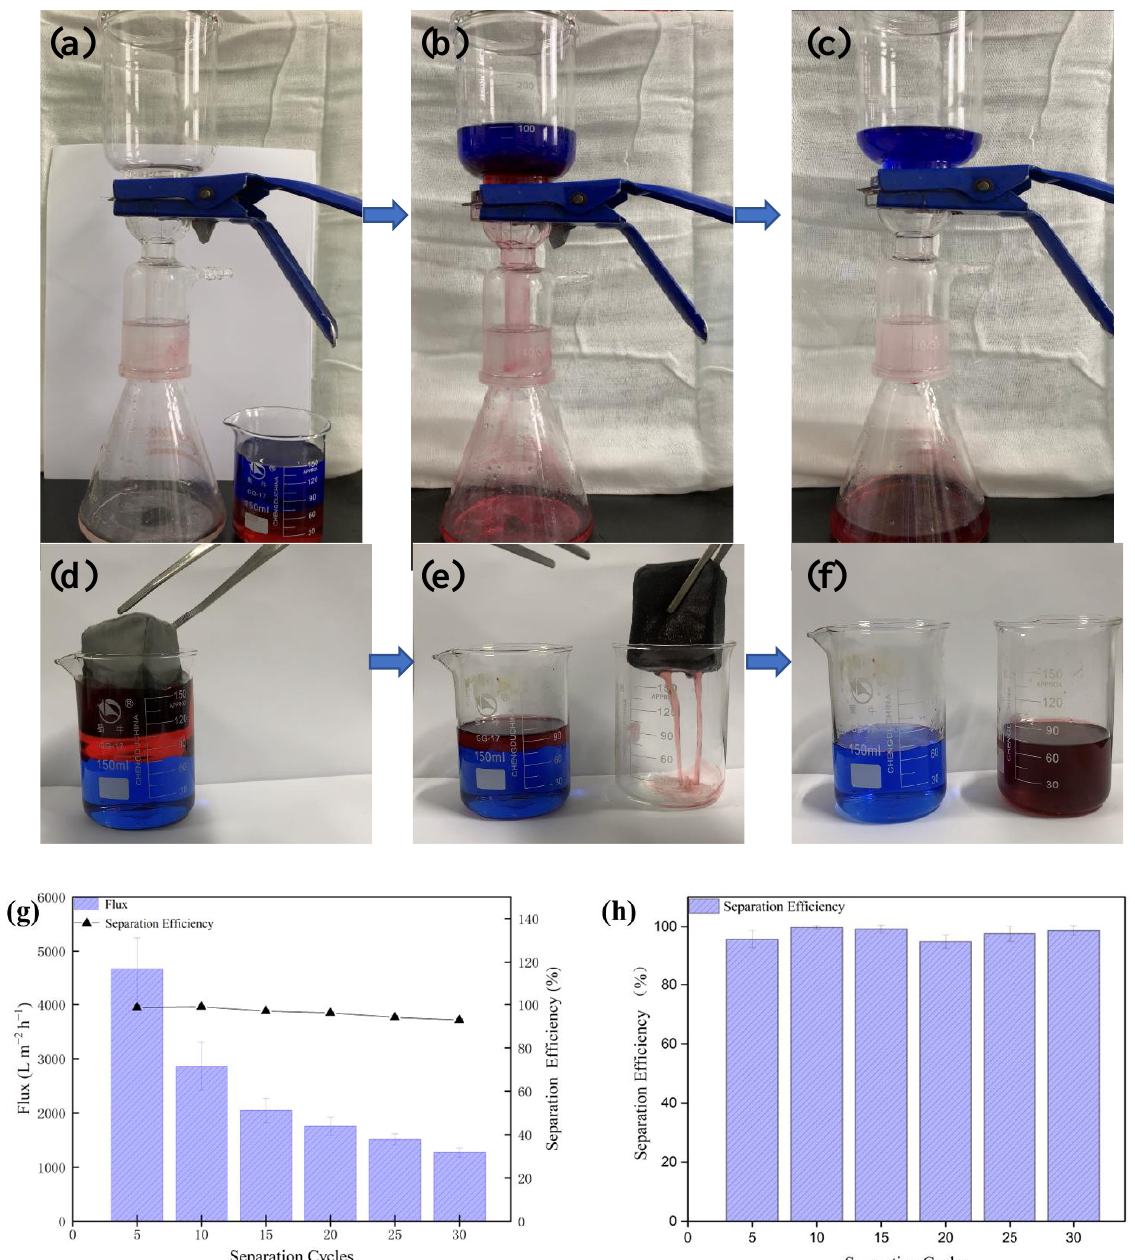
Figure 10. Oil–water separation performance of CA-Fe-SH-PET fabric. ( a – c ) Heavy oil separation by gravity-driven method; ( d – f ) light oil separation by adsorption bag; ( g ) heavy oil separation flux and separation efficiency; ( h ) light oil separation efficiency and recyclability.